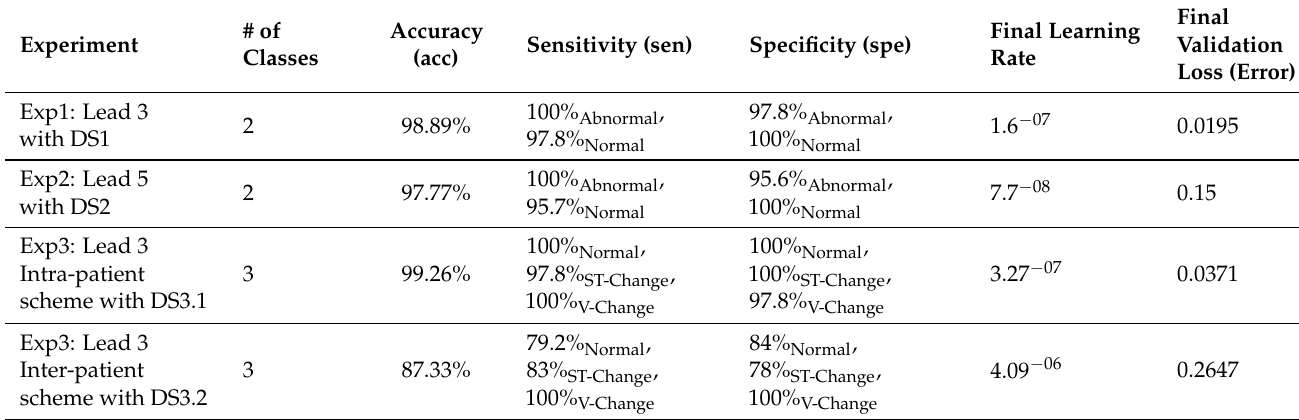
Table 5. Performance results of